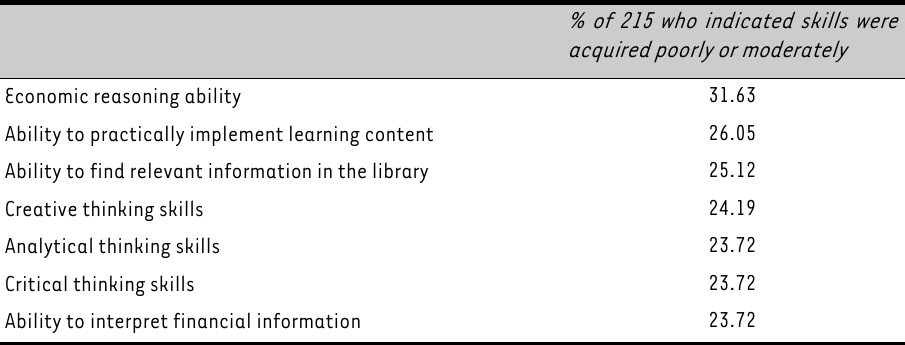
TABLE 1: Skills most frequently identified as having been acquired poorly or to a moderate extent only, in the